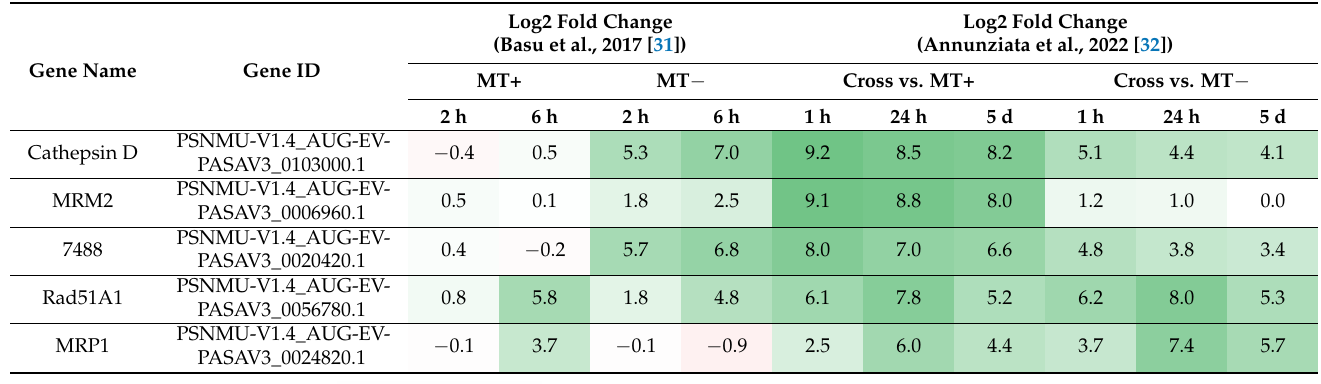
Table 1. List of the most differentially expressed genes selected to study mate perception in Pseudo- nitzschia multistriata . For each of them the corresponding level of induction in sexualized strains at the time points 2 h and 6 h, and in co-cultures at the time point of 1 h, 24 h, and 5 days (d), are indicated